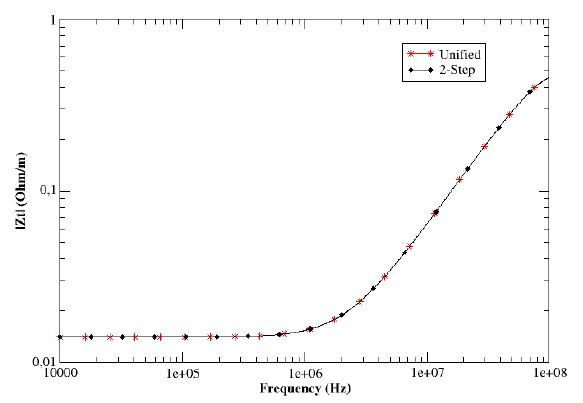
FIGURE 14. Zt simulation with the reference [5] scalar measurement setup. Unified model and two-step approach